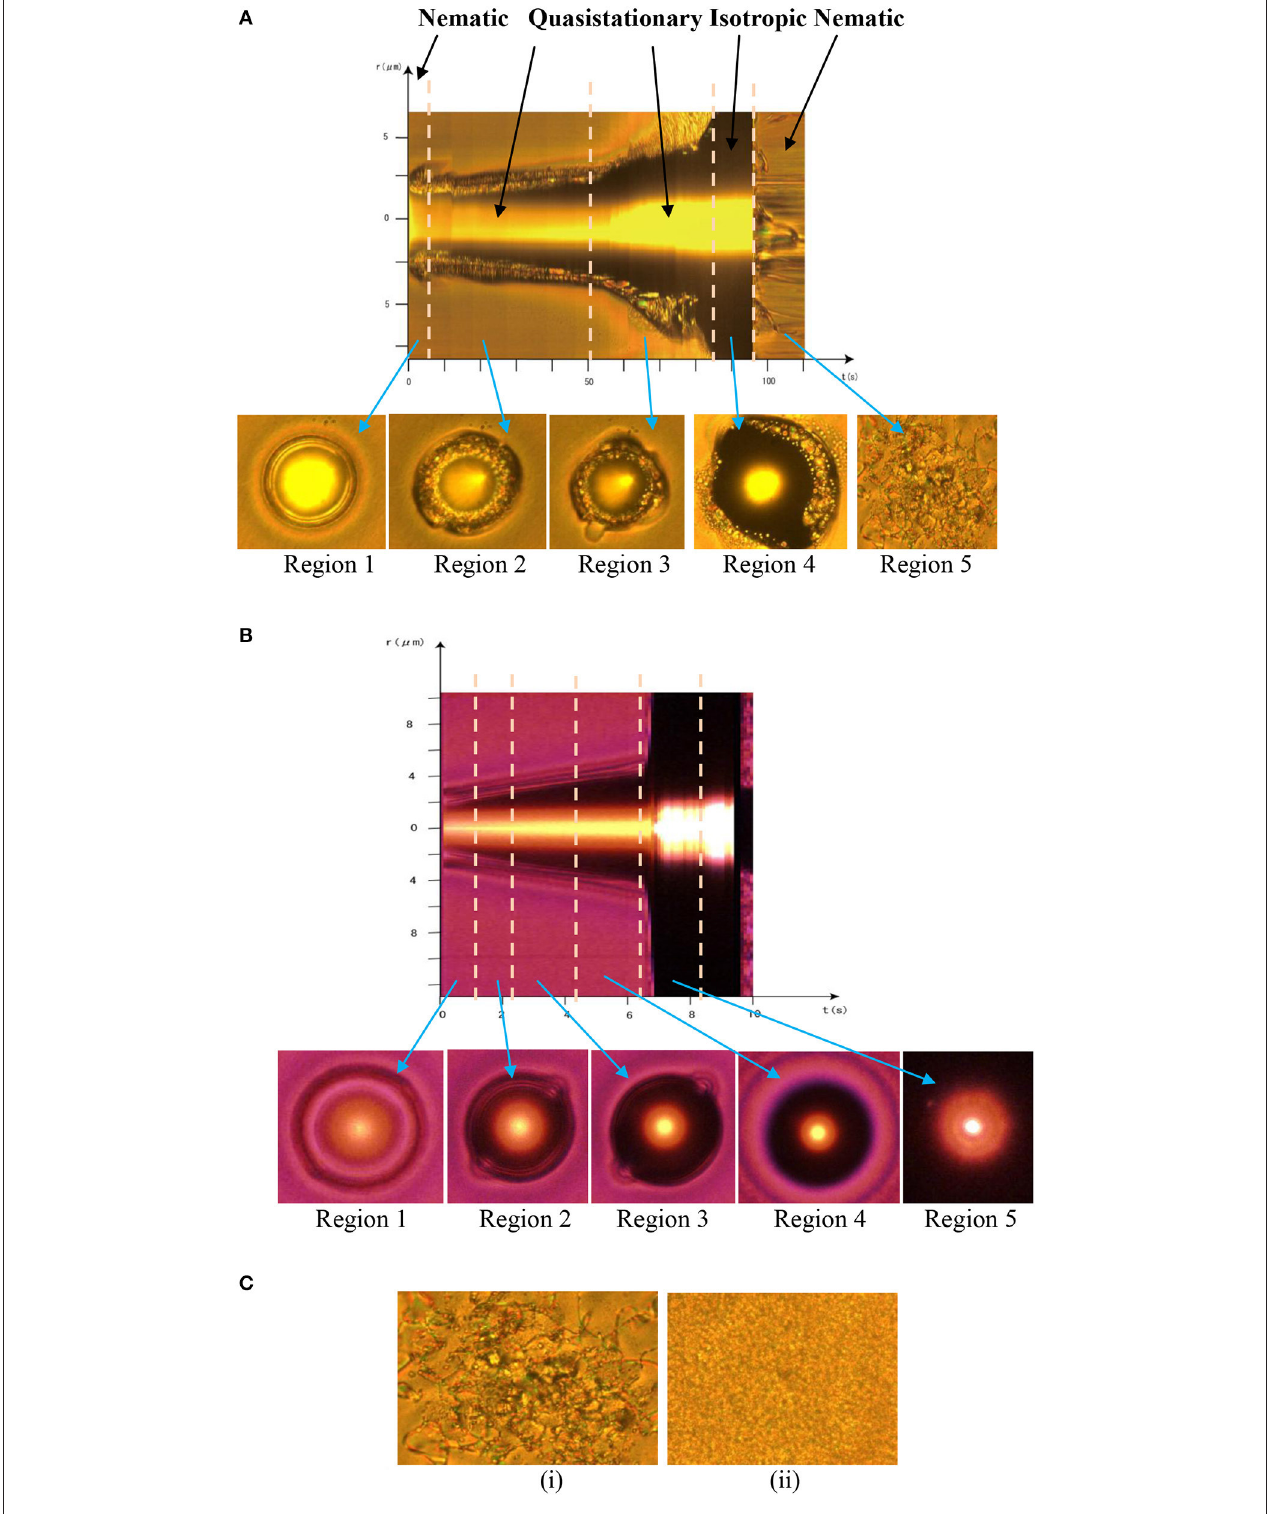
FIGURE 2 | Spatiotemporal evolution of the mixtures. Spatiotemporal maps of (A) EMIF-MBBA (with phases marked) and (B) EMIG-MBBA mixtures ( C max concentration) over the entire evolution at the corresponding T c , extracted from Supplementary Movies 1, 2 , respectively. The different regions in each map are separated by dashed lines and the typical frame of each region is shown below the map, designated by arrows. (C) Frames at (i) 100 µ s and (ii) 300 µ s of irradiation of MBBA only, by the laser. All data were taken at 200 mW of laser power.